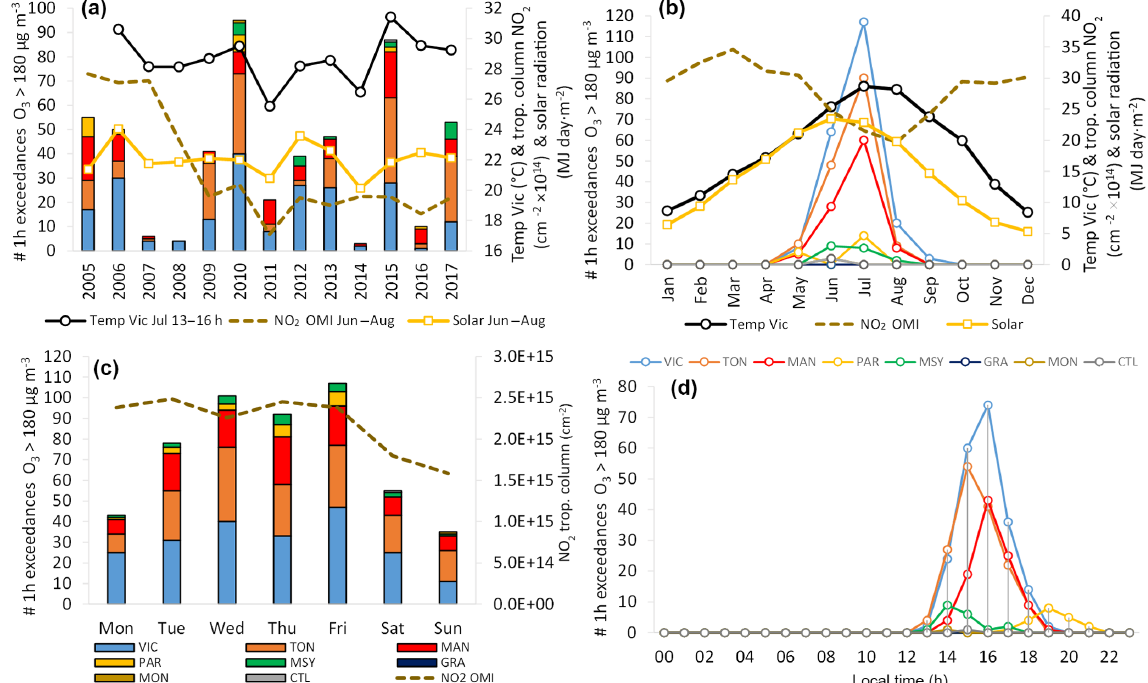
Figure 10. For the period 2005–2017, trends of the EHITs measured by air quality monitoring stations along the S–N axis. (a) Annual trends of the EHITs, average temperatures measured in Vic (Gurb) (July during 13:00 to 16:00LT), background NO 2 measured by OMI- NASA (June to August) and average solar radiation measured at Girona and Barcelona (June to August). (b) Monthly patterns of the EHITs, average temperatures measured in Vic, background NO 2 measured by OMI and solar radiation measured at Girona and Barcelona. (c) Weekly patterns of the EHITs and background NO 2 measured by OMI. (d) Hourly patterns of the EHITs. Despite the incomplete data availability in MAN 2005, almost 20 EHITs were recorded. AQ data from Ciutadella (CTL), Montcada (MON), Granollers (GRA), Montseny (MSY),